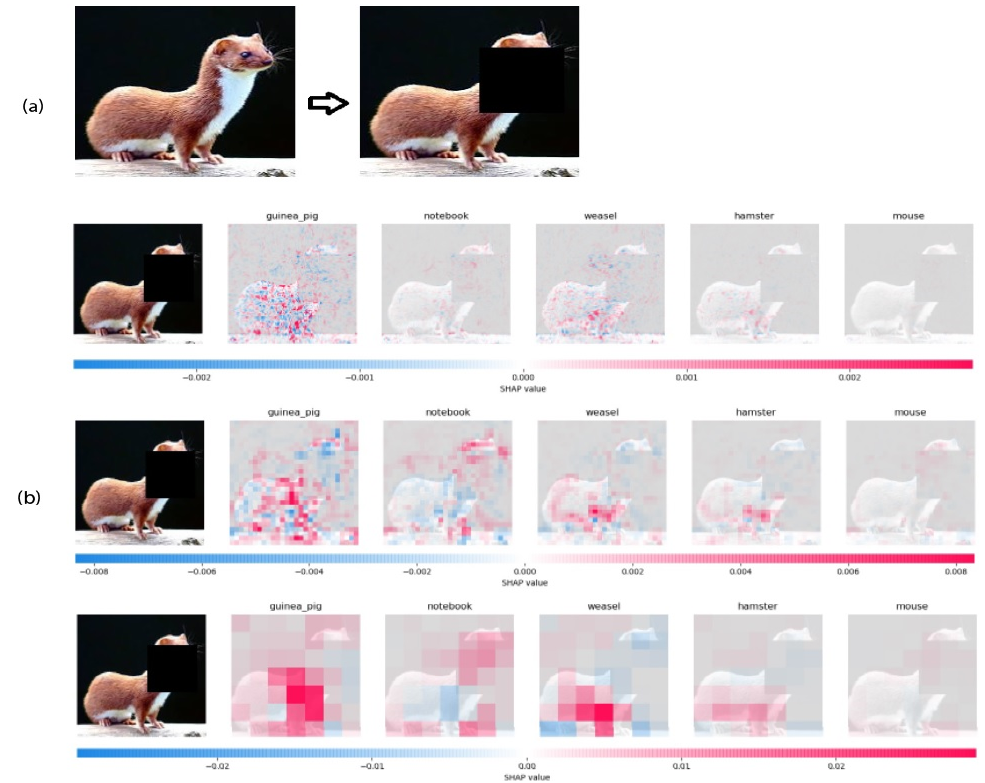
Figure 5. Zoomed in view of VR-based results, ( a ) original image on the left whereas the right image shows the overlaid block occlusion, and ( b ) Shapley-value-based interpretation of the weasel image after being occluded by the VR user. Results are shown for three hidden convolutional layers, where the network strongly predicted the image as being a “guinea pig” instead of a “weasel”.